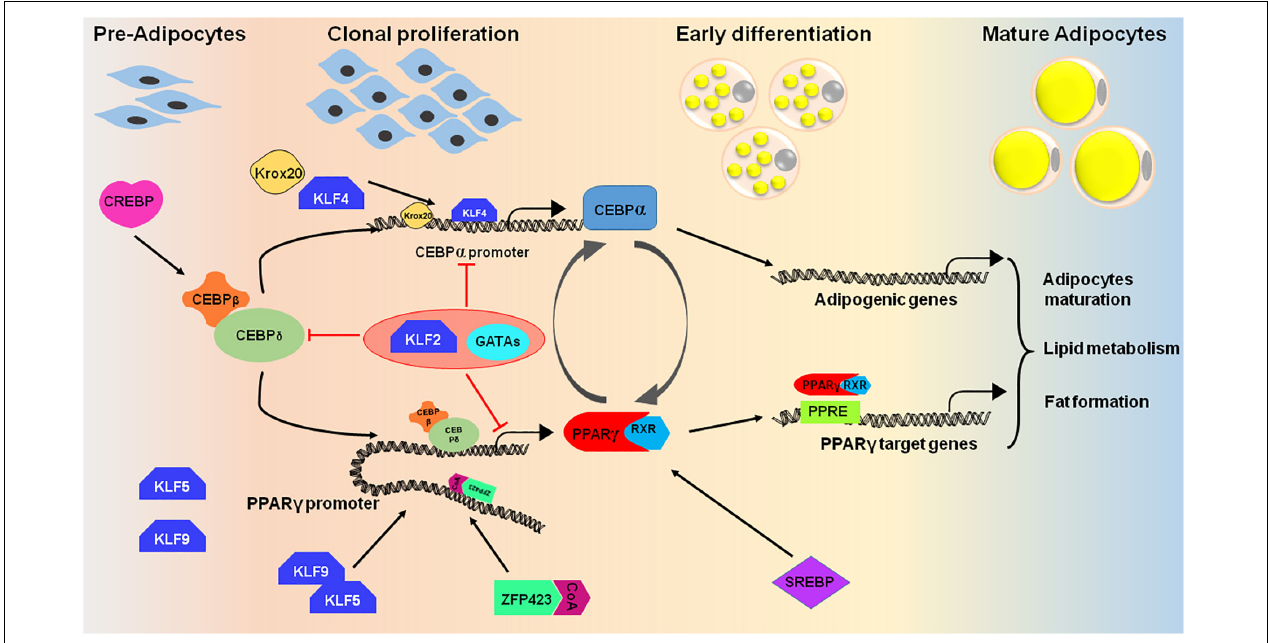
FIGURE 4 | Cascade of transcription factors in adipocyte differentiation. Many transcription factors act as positive regulators that express at different stages of adipocyte differentiation (pre-adipocytes to mature adipocytes). The differentiation process initiates upon induction of cells with adipogenic cocktail which helps in activation of certain transcription factors like CREBP, KLF4, 5, and 9, and CEBP β / δ . CEBP β and CEBP δ triggers the second wave of adipogenesis by activating PPAR γ , CEBP α and SREBP. The PPAR proteins dimerizes with retinoic X receptor (RXR) for interaction with target promoters containing PPAR-response elements. PPAR γ and CEBP α are the key proteins that targets the essential genes required for adipogenesis. To regulate the process of adipogenesis, some transcription factors like KLF2 and GATA2/3 act as negative regulators and inhibits the expression of CEBP α and PPAR γ by direct or indirect repression of the transcription